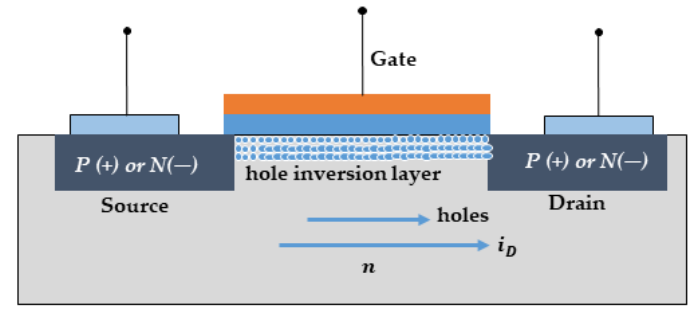
Figure 2. A typical P or N-channel MOSFET illustration.